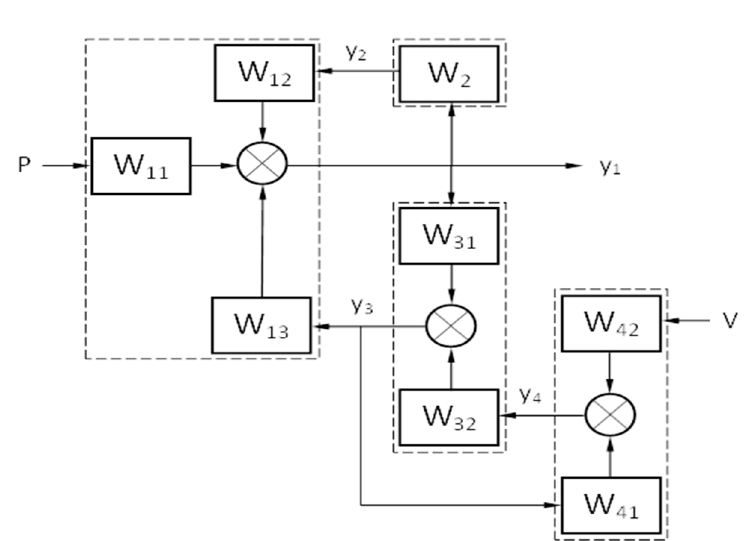
Figure 3. Structural model of dynamic system.